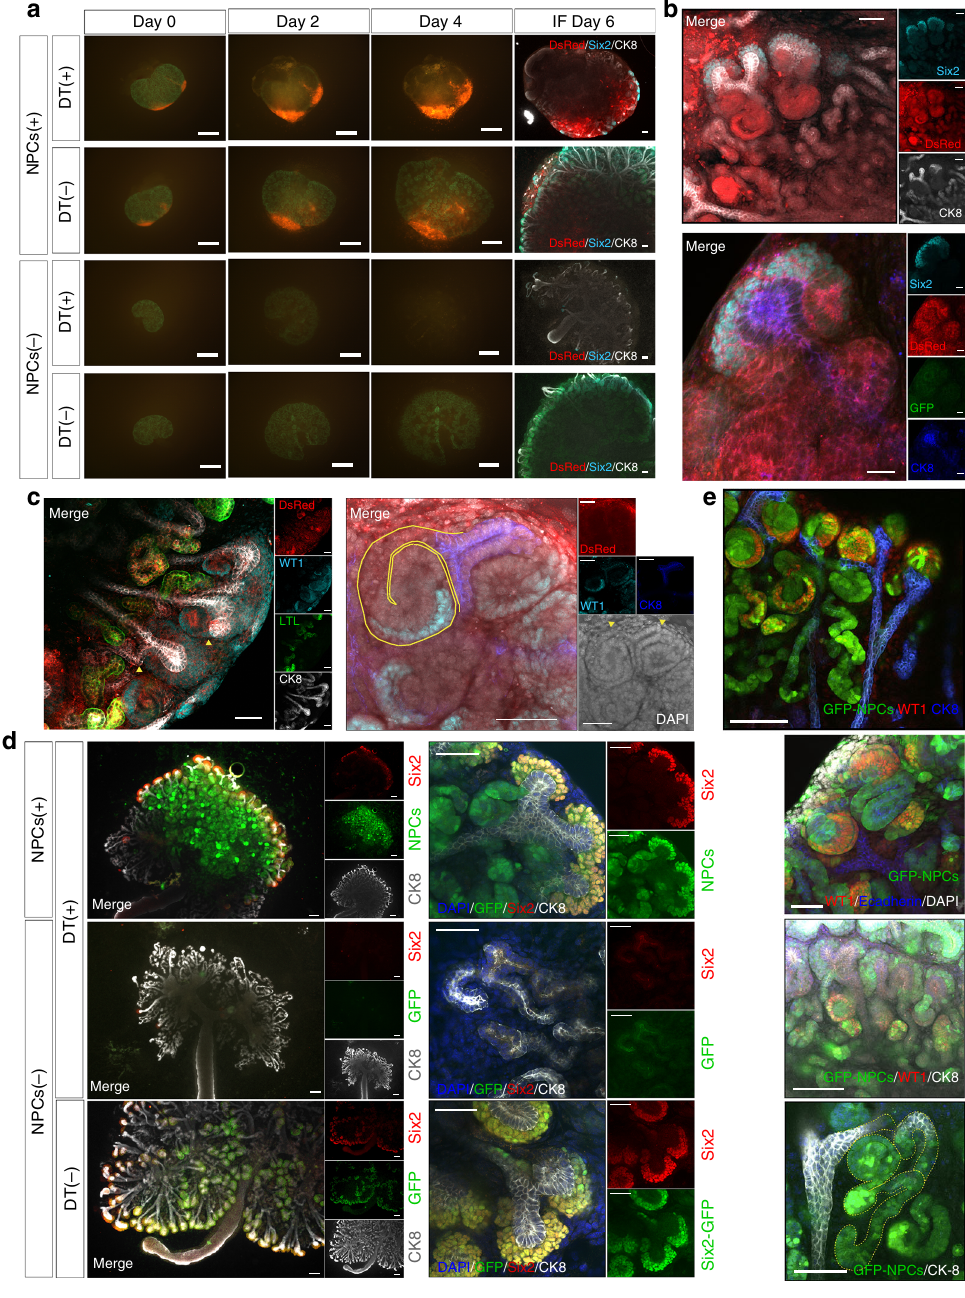
Fig. 5 Elimination of host NPCs combined with donor NPC transplantation in the nephrogenic zone resulted in regeneration of nephrons. a The isolated metanephros (MN) of Six2-iDTR was examined for four groups: (1) transplantation of DsRed-NPCs and daily administration of diphtheria toxin (DT; top column); (2) transplantation of DsRed-NPCs and no administration of DT (second from top column and right); (3) no transplantation of DsRed-NPCs and daily administration of DT (third from top column); (4) no transplantation of DsRed-NPCs and no administration of DT (scale bar, days 0 – 4: 500 µ m; day 6: 100 µ m). b DsRed-NPCs expressing Six2 were present on the CM (upper column; scale bar, 50 µ m). Six2-positive cells expressed DsRed, but not GFP (lower column; scale bar, 20 µ m). c DsRed-NPCs epithelialized nephrons, including glomeruli (WT1 positive) and renal proximal tubules (LTL positive). Epithelialized nephrons derived from donor cells connected the host collecting ducts (yellow triangle and yellow line; scale bar, 50 µ m). d Transplanted cells changed DsRed-NPCs to GFP-NPCs. Animals were transplanted with or without GFP-NPCs and treated with or without DT daily (scale bar, 100 µ m). Seven days later, samples were immunostained and observed. d Transplanted GFP-NPCs were integrated into the CM with Six2 expression and epithelialized vesicles (top). d Six2-GFP cells were absent, and poor branching of the ureteric bud, which did elongate but had an extremely deformed shape with many distortions, was observed (second from top). d The Six2-iDTR MN harbored GFP-expressing cells, whereas epithelialized nephrons including glomeruli and renal tubules showed no GFP expression (bottom) (left scale bar, 100 µ m; right scale bar, 50 µ m). e Transplanted GFP-NPCs had WT1-positive glomeruli (top column; scale bar, 100 µ m) and E-cadherin-positive distal convoluted tubules (second from top; scale bar, 100 µ m). These neonephron structures were connected to the ureteric bud sprouting from the host MN (second from bottom, bottom; scale bar, 100 µ